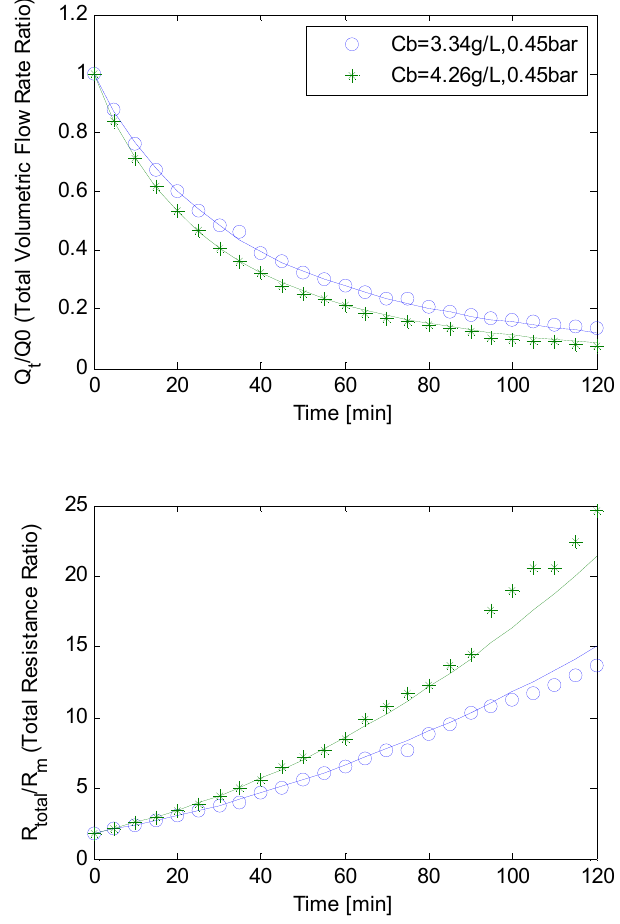
Figure 7. Flux decline and total resistance for flux step at TMP 45 kPa for